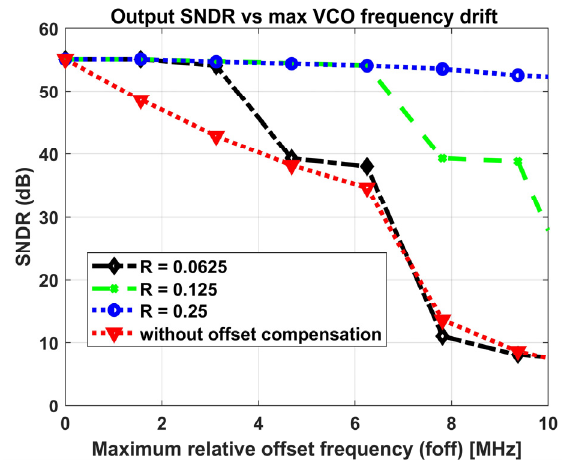
Figure 11. Variation in the measured SNDR of the output with the magnitude of maximum relative offset frequency of the two VCOs.